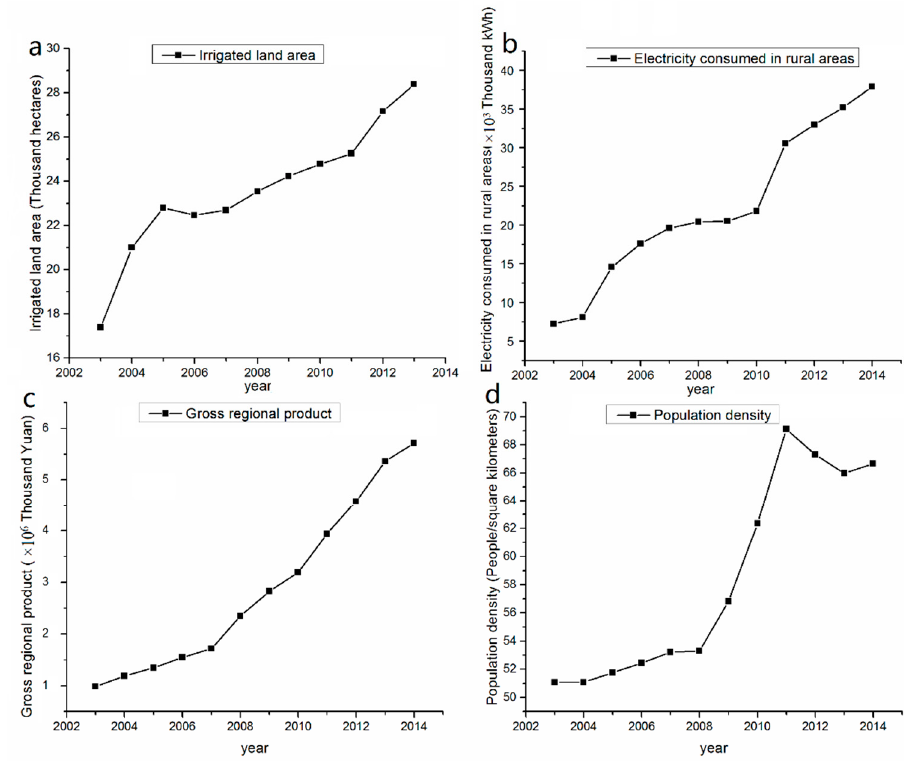
Figure 8. Yearly change tendency of ( a ) annual irrigated land area, ( b ) annual electricity consumed in rural areas, ( c ) annual gross regional product, and ( d ) and annual population density.